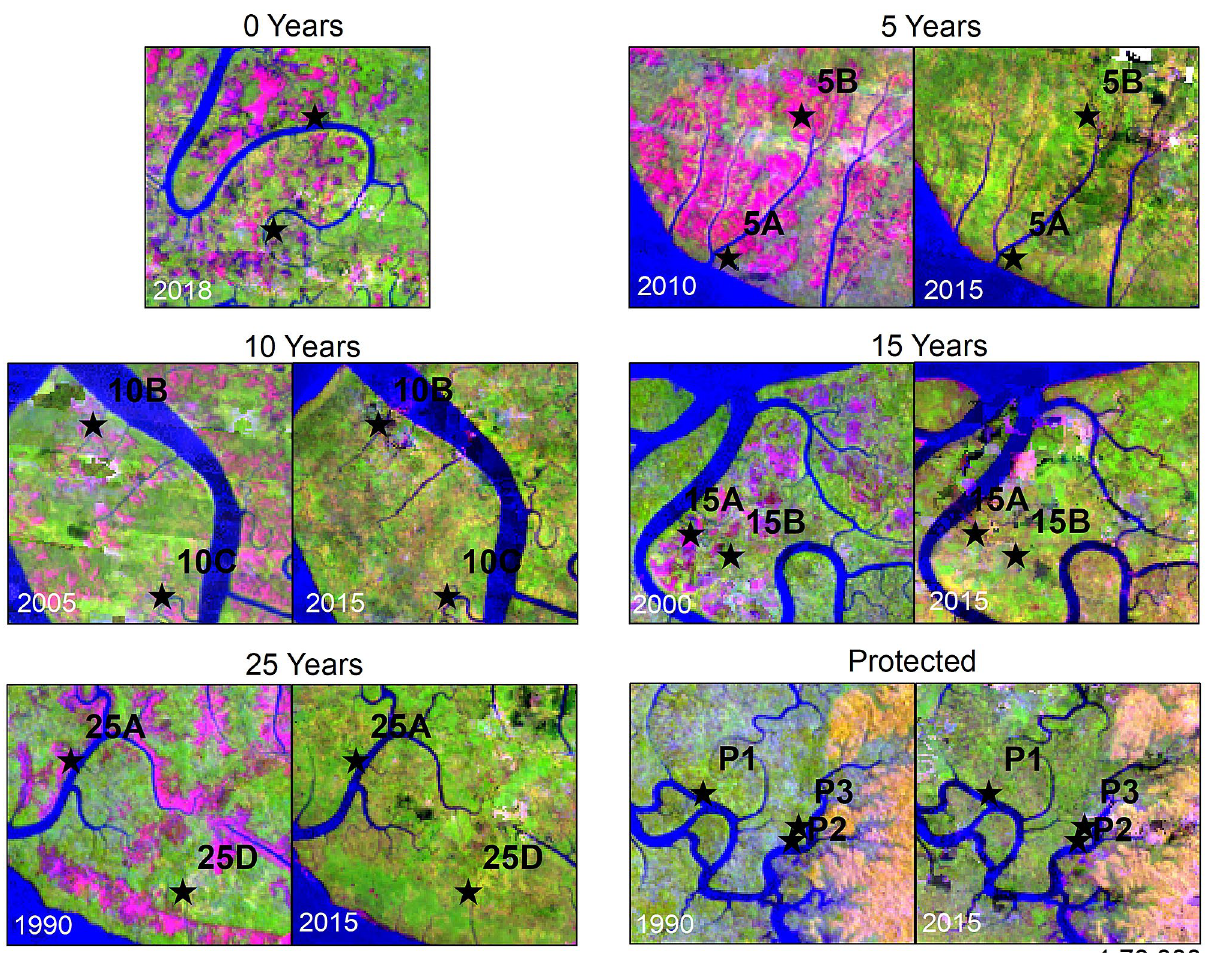
Figure 3. Landsat snapshots (1:70,000 scale) displayed in false colors (Red: Short-wave infra-red; Green: near infra-red; Blue: Red) show the recovery process after logging. Cloud-like pink patches in images of the initial years of logging reveal the ‘keyhole’ pattern of logging in this mangrove forest, from where measurements of carbon were taken. Comparisons between the year when logging took place (left panel of each year) and the situation in 2015 (right panel of each year) across all sampling plots, except for the Year 0 plot (sampled in 2018), show a regreening of logged